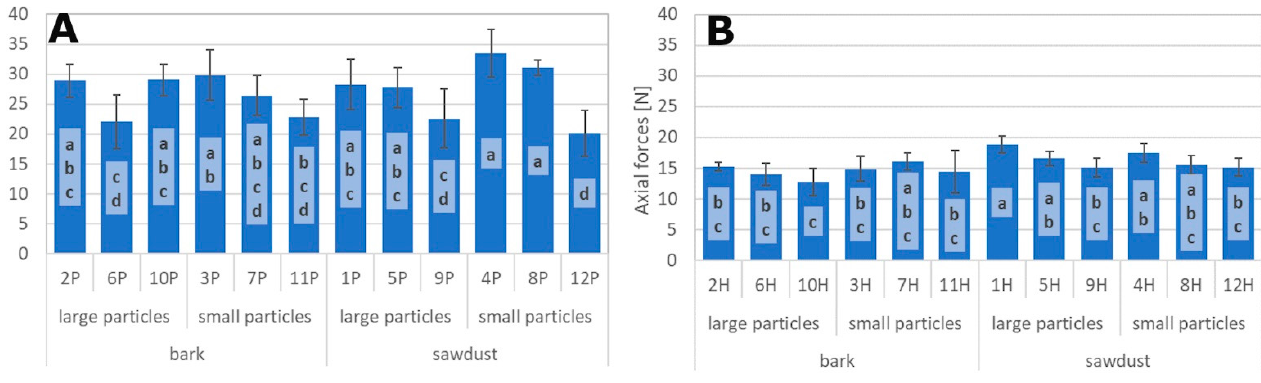
Figure 4. Values of axial forces during drilling of PLA-based composites ( A ) and HDPE-based com- posites ( B ) (a, b, c, d—homogeneous groups by Tukey’s test).